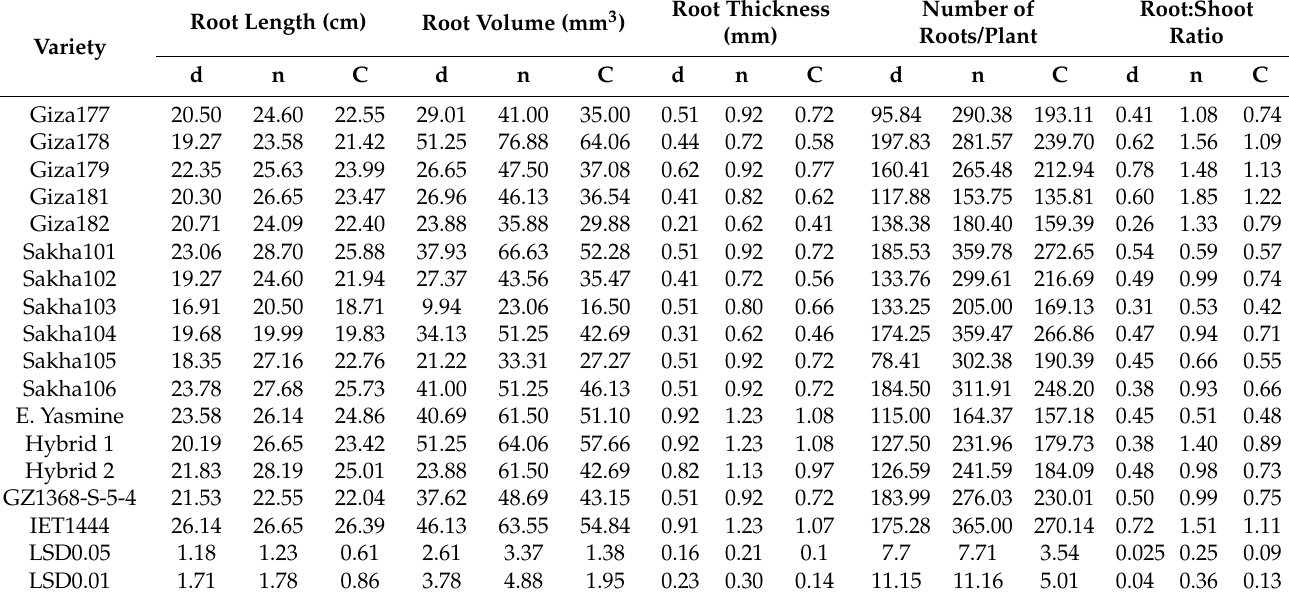
Table 6. Performance of Growth characteristics under normal and drought conditions and their combined